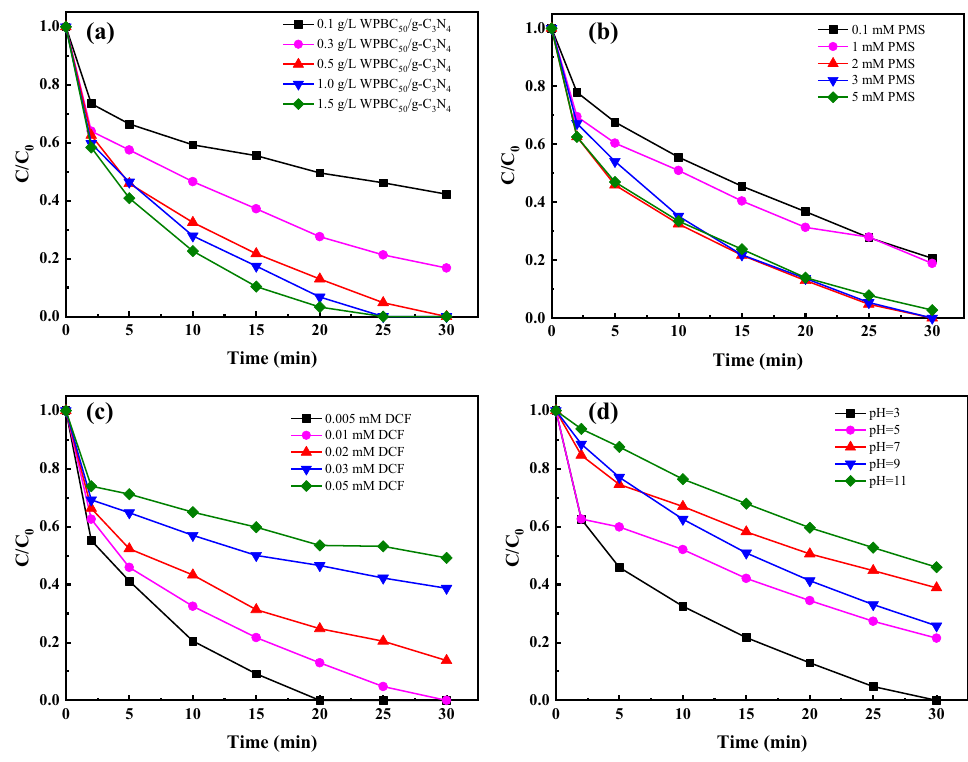
Fig. 11 Effects of a catalyst dosage, b PMS concentration, c DCF concentration, and d initial pH on the degradation of DCF (conditions: [catalyst] 0 = 0.5 g/L, [PMS] 0 = 2.0 mM, [DCF] 0 = 0.01 mM, pH 0 = 3.20 ±